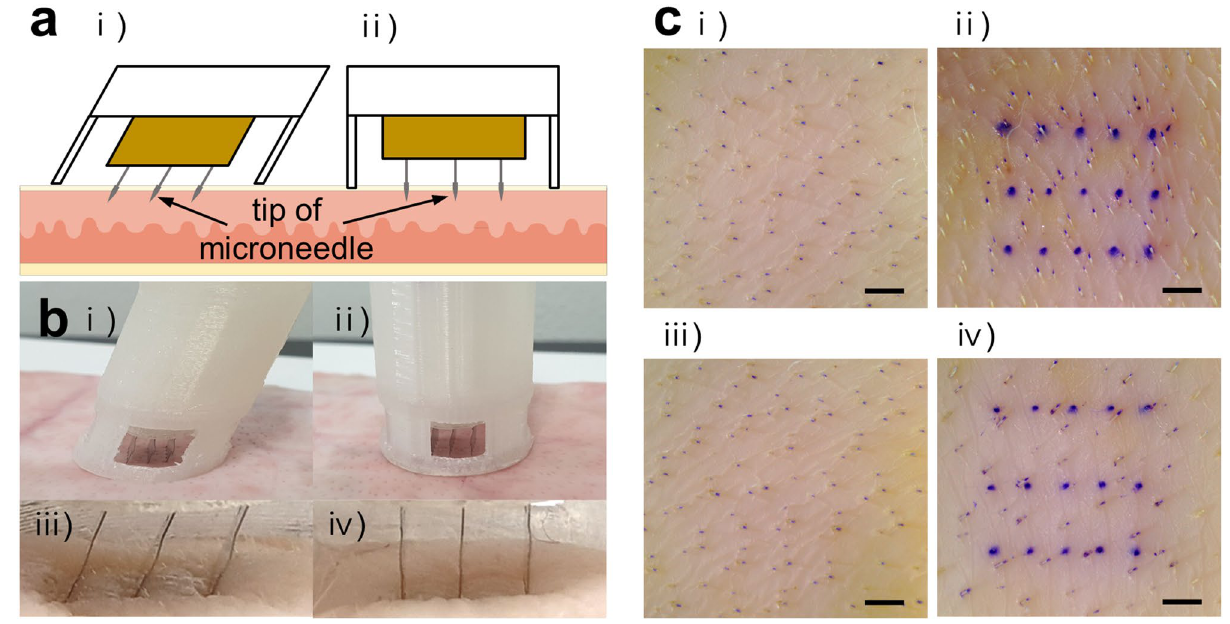
Figure 2. Ex vivo skin penetration test using the MN devices. ( a ) Schematic illustration of the MN insertion into a porcine skin ex vivo by TMICS (i) and SMICS (ii). ( b ) Digital images of the MN penetration by TMICS (i) and SMICS (ii). TMICS MNs penetrated the skin with a tilted state (iii), and SMICS MNs penetrated vertically (iv). ( c ) Optical images of the skin before (i and iii), and after skin penetration by TMICS (ii) and SMICS (iv). The scale bars are 1 mm (n = 3).